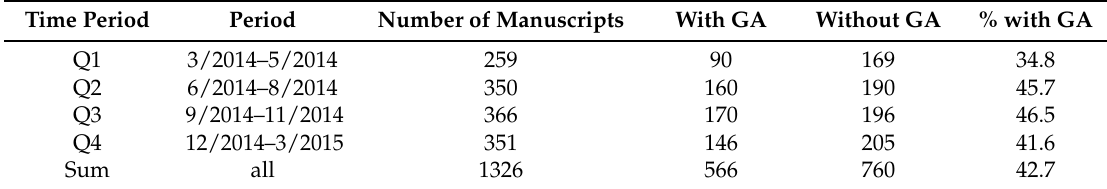
Table 2. Arrangement of evaluated manuscripts regarding the time of